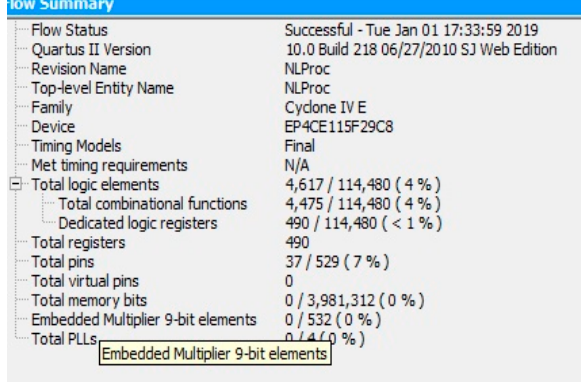
Table 6. F1 scores of various Spoken Language Processing System (SLPS) implementations.